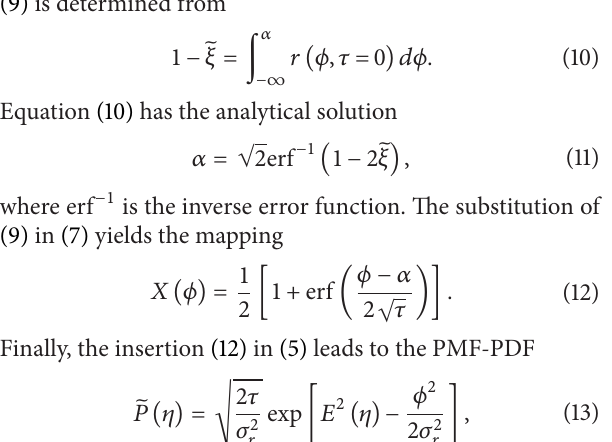
Table 1: Conditions of the lifted flame of Cabra et al.